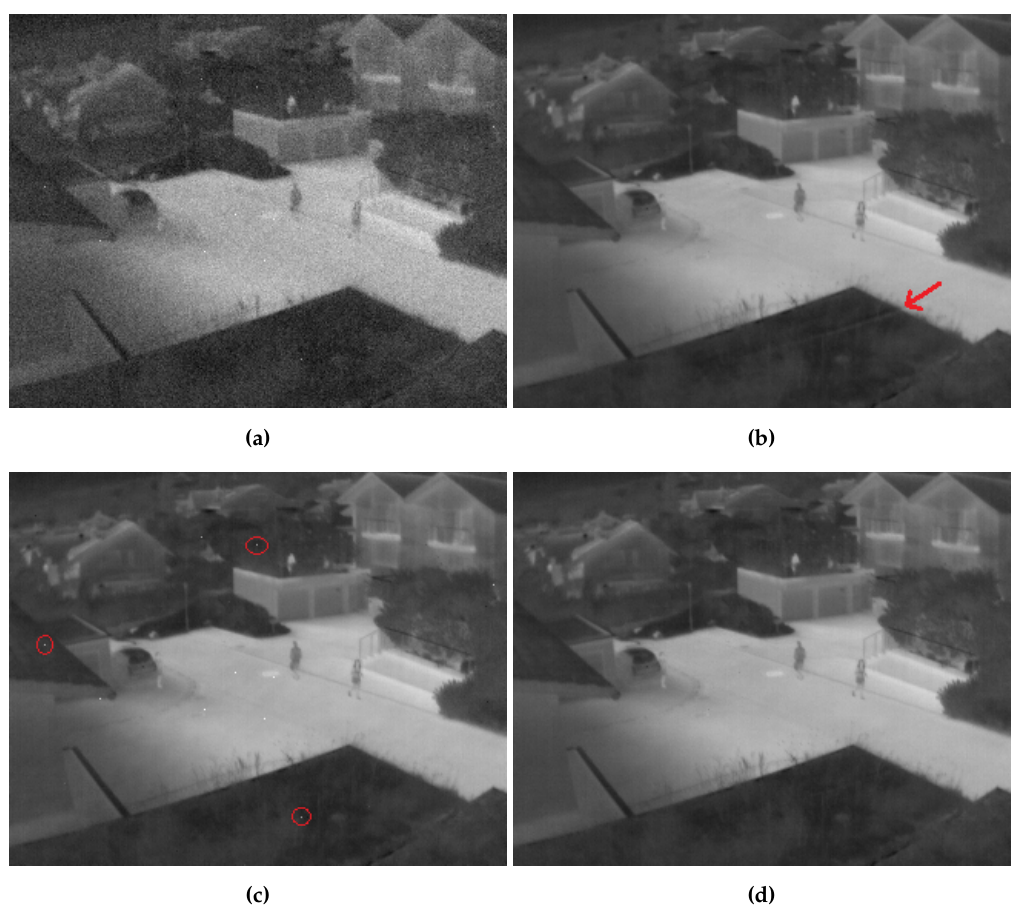
Figure 6. Frame 250 of sequence 1 ( a ) with simulated nonuniformity; ( b ) corrected with the adaptive algorithm; ( c ) corrected with registration-based algorithm; and ( d ) corrected with proposed algorithm. Both nonuniform and corrected sequences are represented in video 1 and video 2